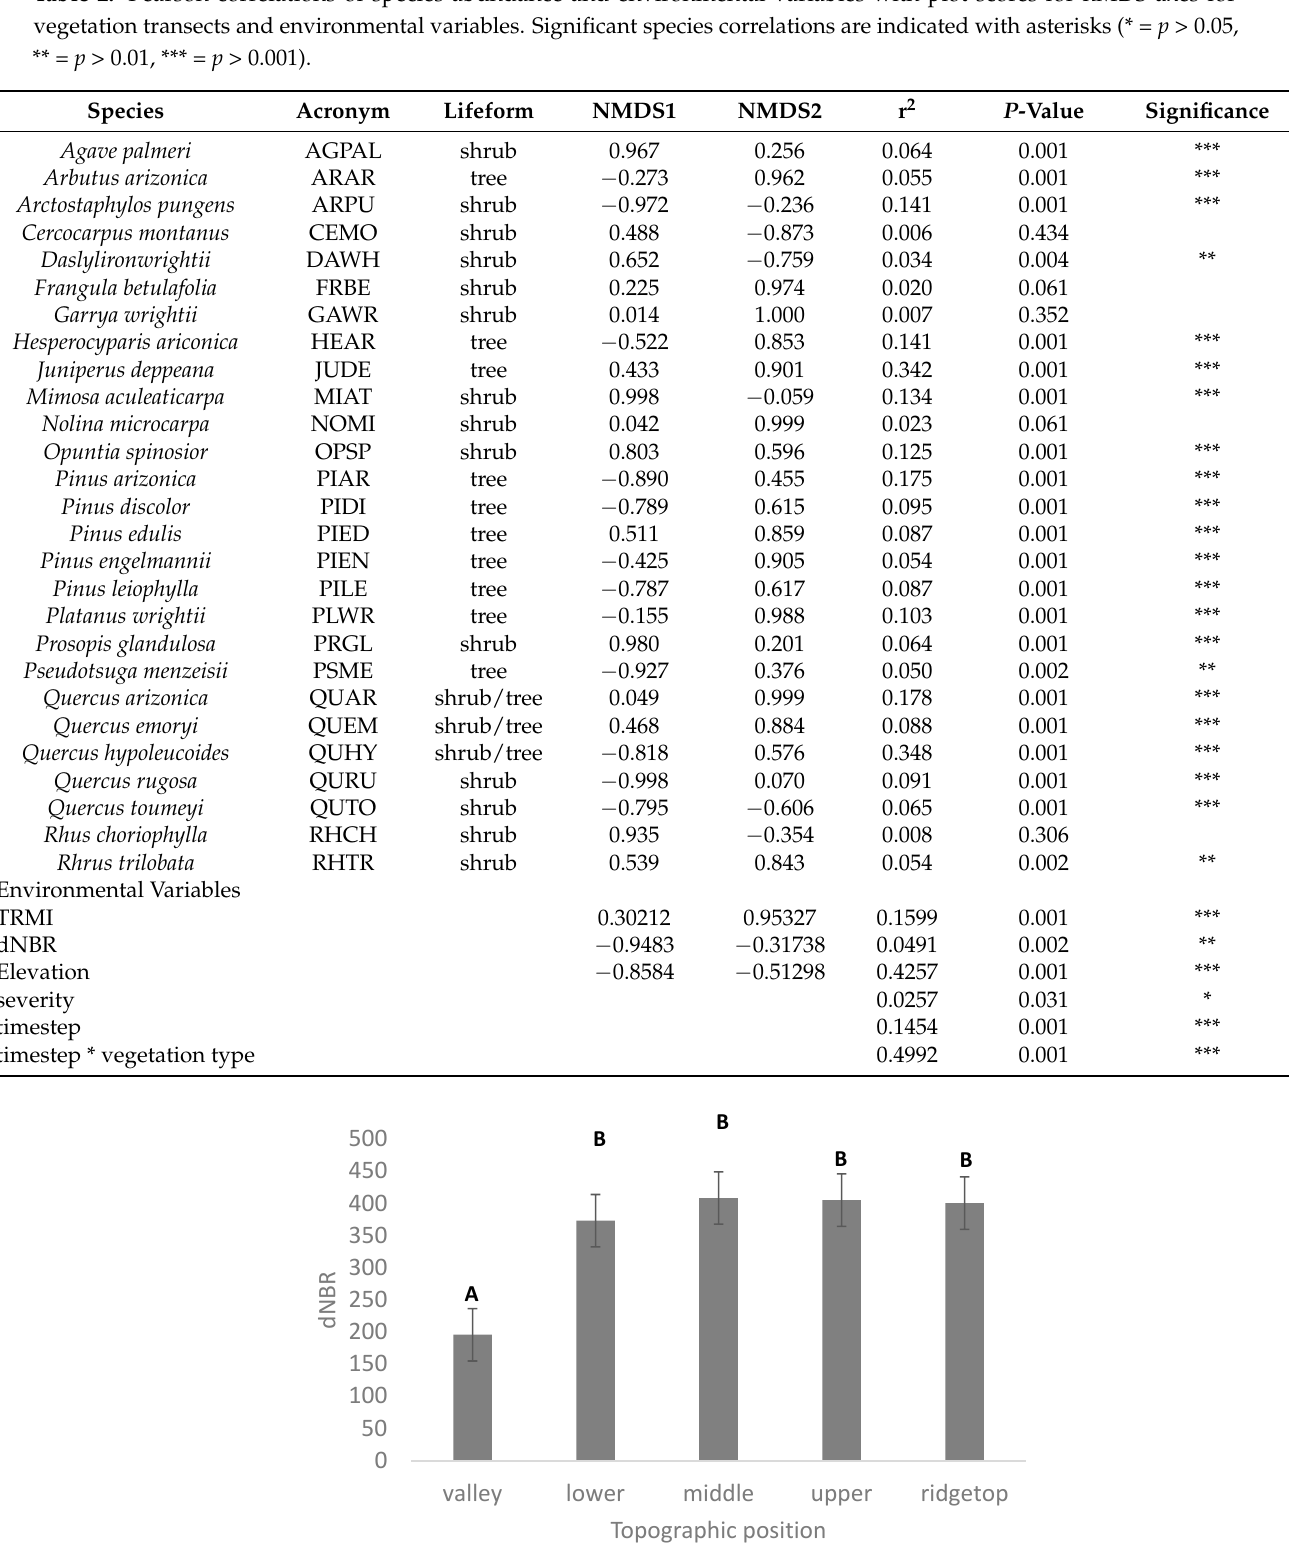
Figure 3. Mean dNBR fire severity (+/ − 1 S.E.) grouped by topographic position: valley ( n = 50), lower ( n = 36), middle ( n = 30), upper ( n = 28), and ridgetop ( n = 38) in Chiricahua National Monument, Arizona. Letters indicate significant post-hoc Tukey’s pairwise differences in dNBR and TRMI among topographic positions. Bars that do not share a letter differ significantly at p < 0.05.